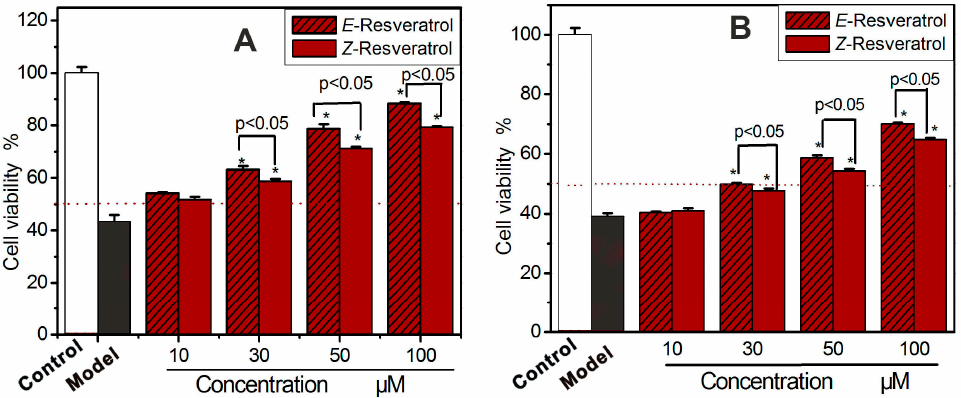
Figure 3. Cytoprotective effects of two resveratrols on oxidatively damaged bmMSCs: ( A ) bmMSCs were damaged by H 2 O 2 ; ( B ) bmMSCs were damaged by Fenton reagent (i.e., addition of 100 µ M FeCl 2 followed by 50 µ M H 2 O 2 ). The control group was cultured in medium only, while the model group was treated with H 2 O 2 (or Fenton reagent). The resveratrol group was damaged by H 2 O 2 (or Fenton reagent) followed by E - or Z -resveratrol. Each value is expressed as the mean ± SD, n = 3; * Significant difference vs the model group, p < 0.05. Cell viability was assessed using the MTT method. bmMSCs, bone marrow-derived mesenchymal stem cells; MTT, methyl thiazolyl tetrazolium.